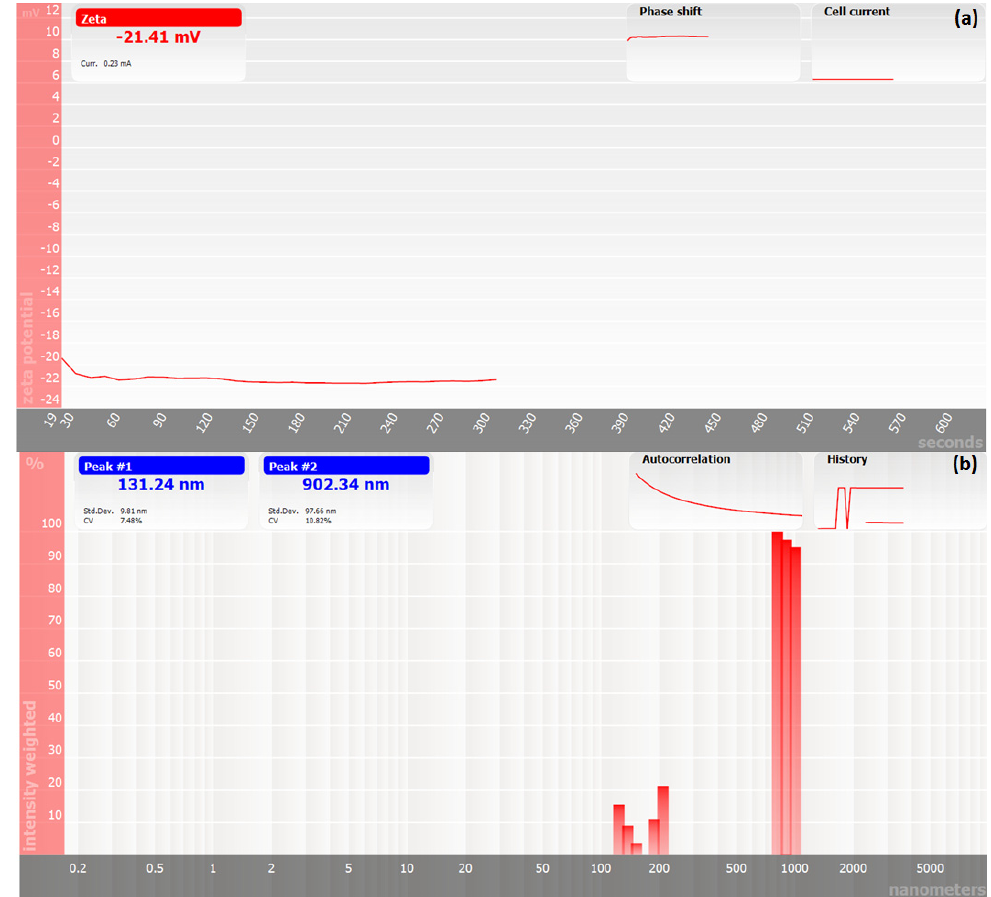
Figure 6. ( a ) The zeta potential (mV) and ( b ) the particle size (nm).